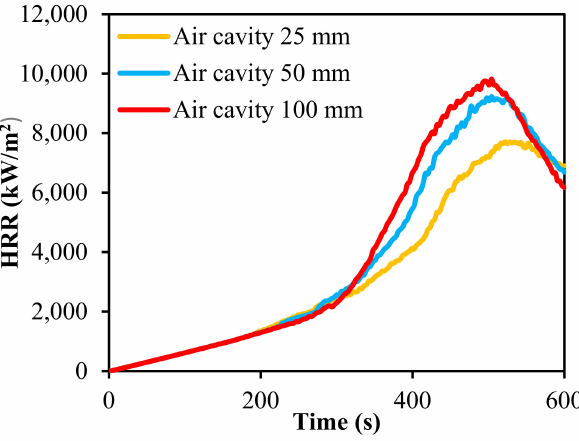
Figure 12. Effect of air cavity on